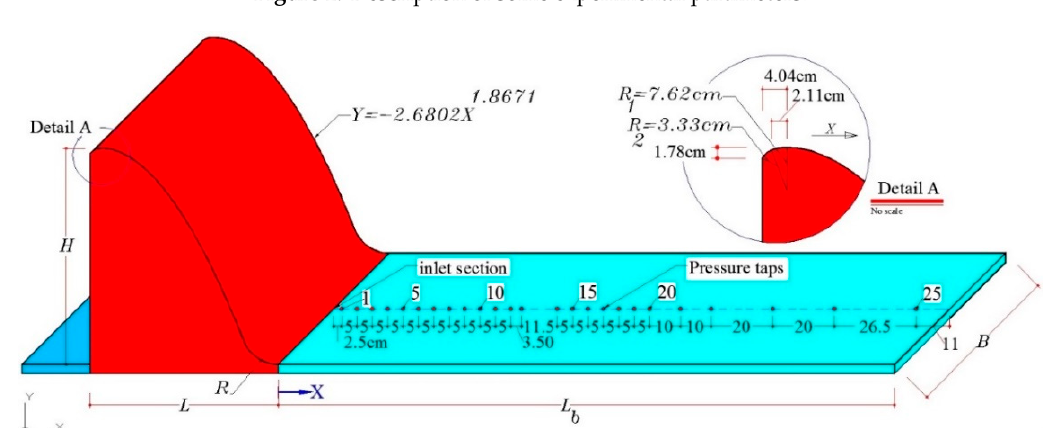
Figure 3. Distribution of pressure taps along the stilling